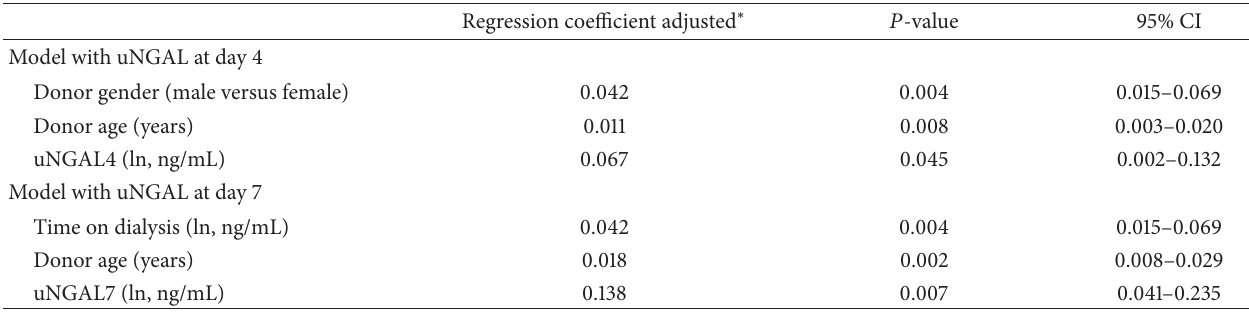
Table 7: Significant factors associated with serum creatinine at one year after kidney